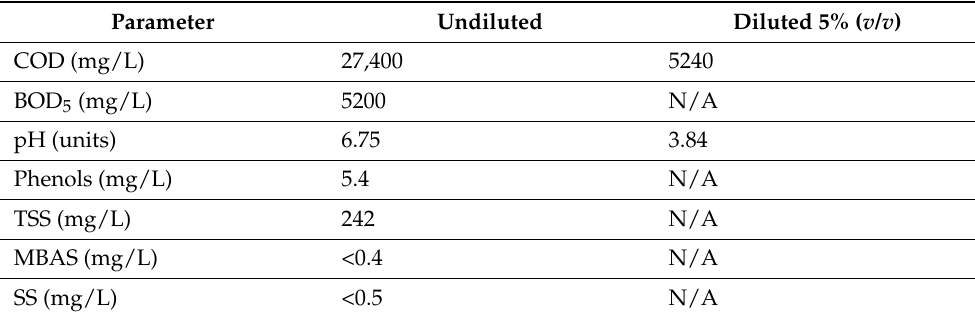
Table 1. Clinical laboratory wastewater